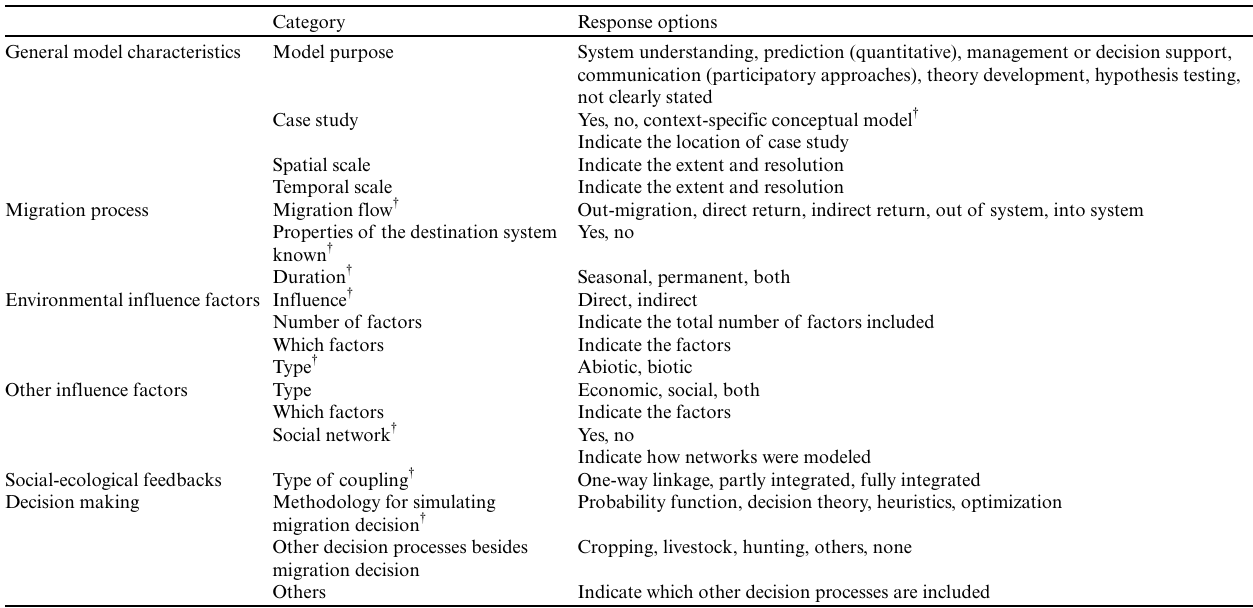
Table 2 . Categories to classify the reviewed agent-based models. The † marks terms that are explained in the text.